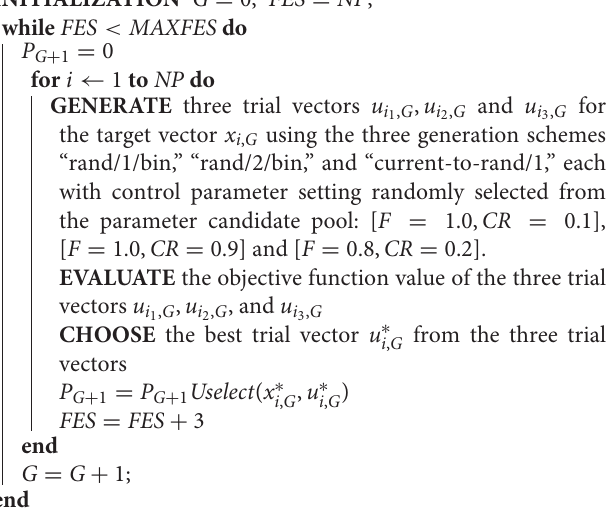
Algorithm 2: Pseudocode of